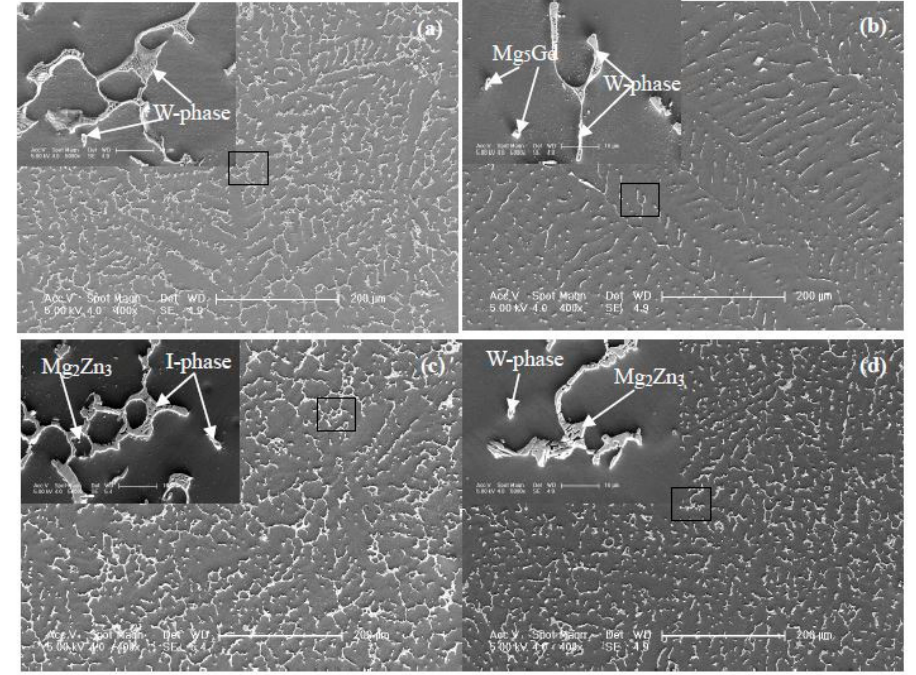
Figure 3. Second electronic image (SEI) of Mg-Zn-Gd alloys (Zn/Gd ratio, sample No.): ( a ) Mg-1Zn-2Gd (0.5, Sample 35), ( b ) Mg-1Zn-0.333Gd (3, Sample 39), ( c ) Mg-5Zn-0.278Gd (18, Sample 10), and ( d ) Mg-5Zn-0.083Gd (60, Sample 14). Table 2. Energy-dispersal X-ray spectroscopy (EDS) analysis of the compounds in Mg-Zn-Gd alloys along with scanning electron microscopy (SEM) (D-Dendritic, P-Particle, M-Matrix). Mg Zn Gd Zn/Gd Compound Alloys (Zn/Gd Ratio) Location at.% at.% at.% ratio Remarks Mg-1Zn-2Gd (0.5) D 90.87 D 79.10 13.88 1.97 Mg-1Zn-0.333Gd (3)